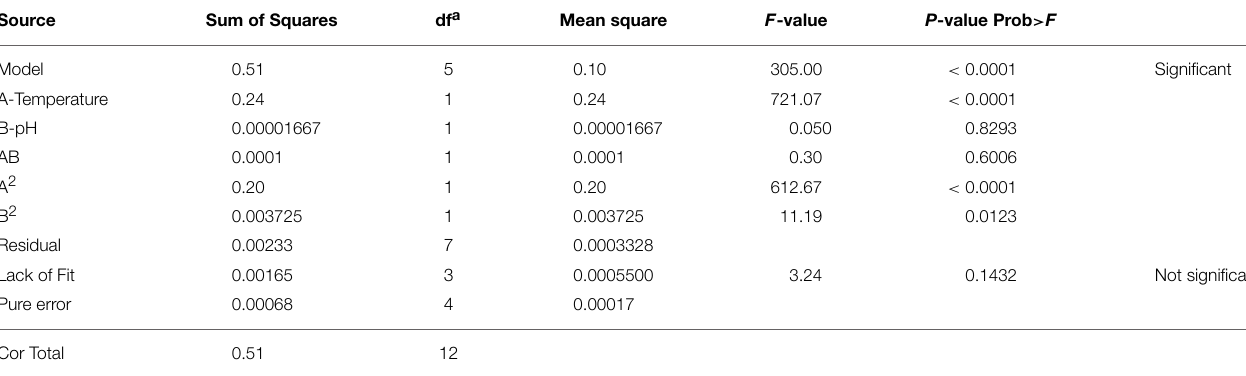
TABLE 4 | ANOVA for the experimental results of the FCCD for K. marxianus NIRE-K1. Source Sum of Squares df a Mean square P -value Prob > F